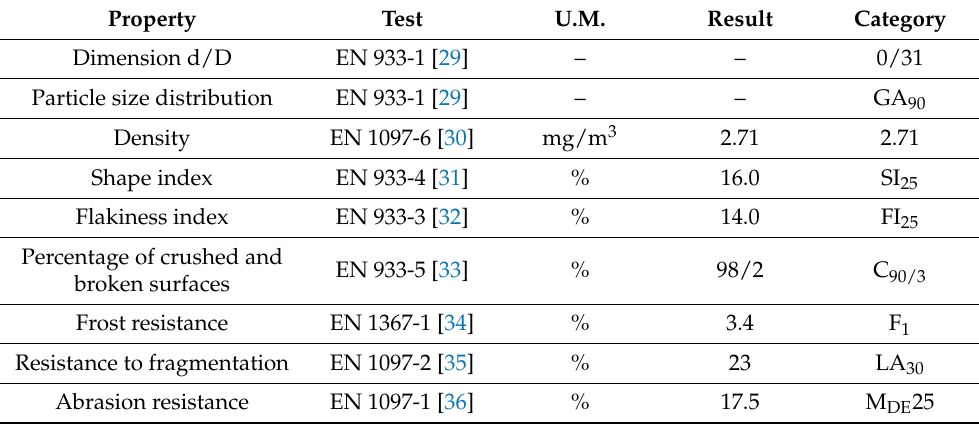
Table 1. Properties of aggregate VA 0/31.5.